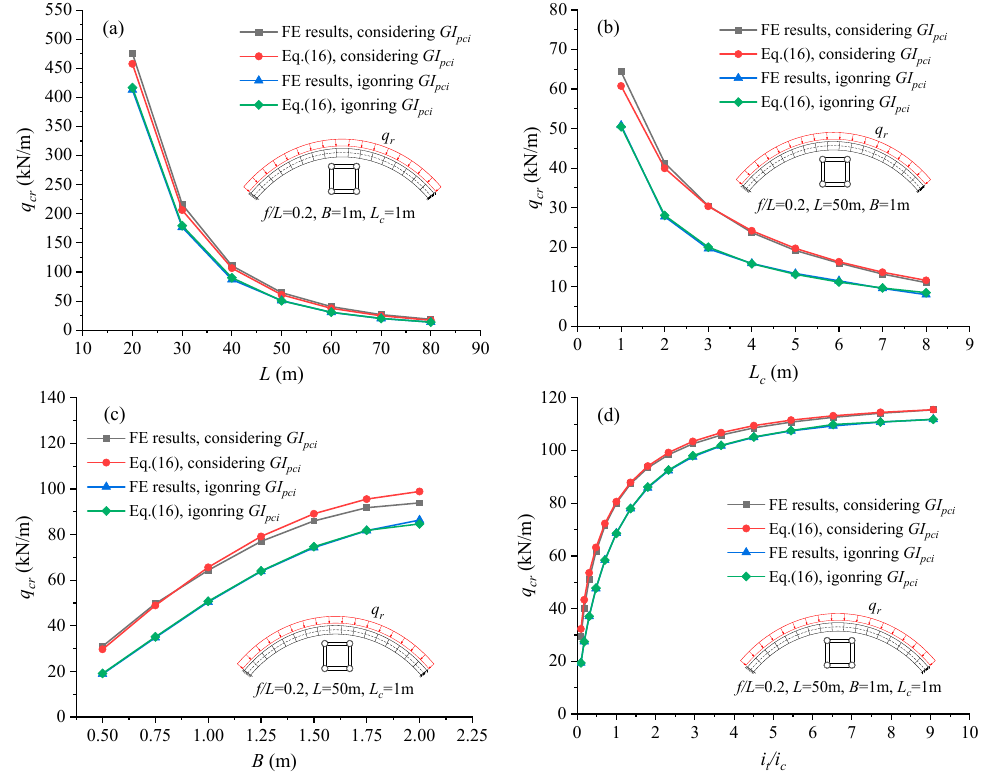
incorporating the torsional sti ff ness of chords are remarkably larger than that ignoring the torsional e ff ects.